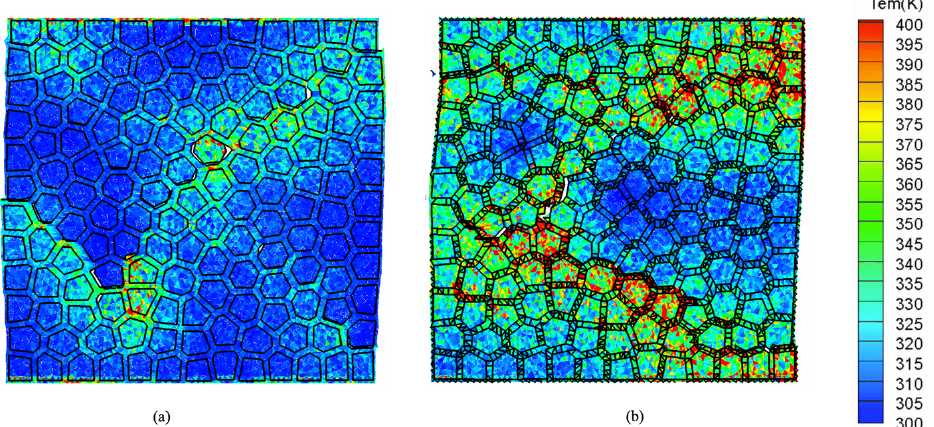
Figure 6. Hot-spot generation with different grain volume fraction under compressive loading ( a ) Vol = 64%; ( b ) Vol =